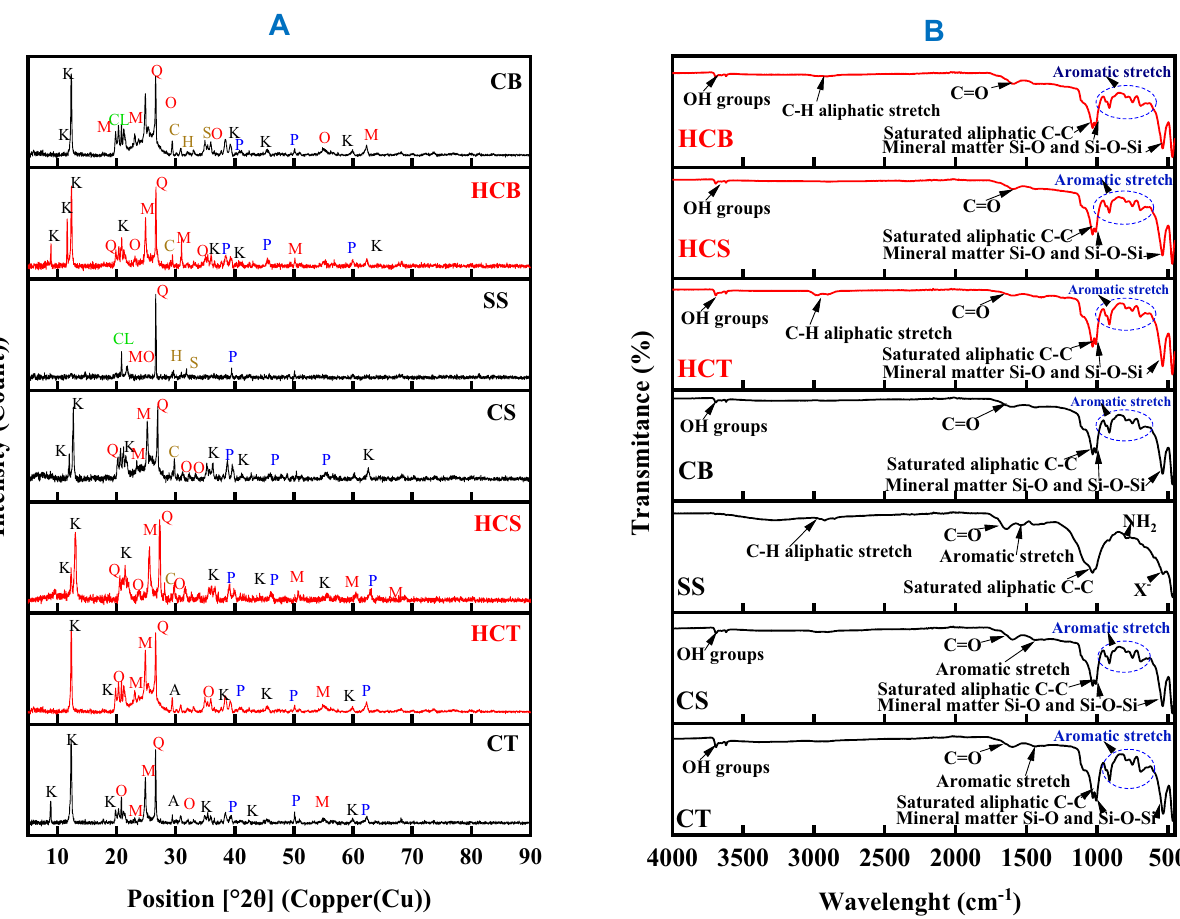
Figure 10. XRD patterns of coal, sewage sludge and produced hydrochar ( A ) and FTIR spectra of coals, sewage sludge and produced hydrochar ( B